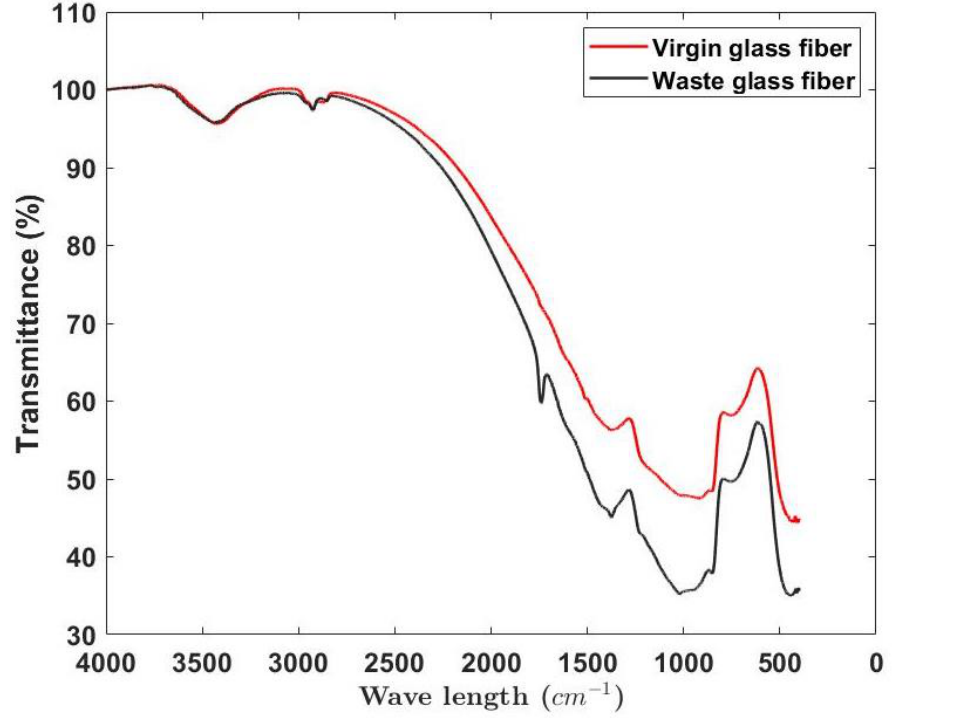
Figure 5. FTIR spectra of virgin and waste glass fibers.